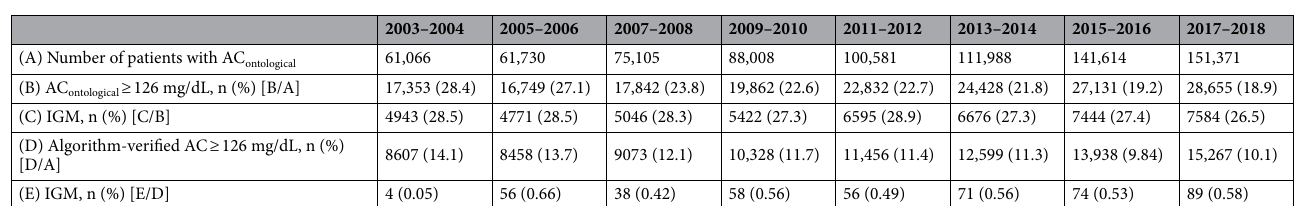
Table 4. Prevalence of fasting glucose ≥ 126 mg/dL and the proportion of ineffective glucose measurement (IGM) from 2003 to 2018 at China Medical University Hospital. The alphabet A to E represents the number of each condition and the proportion of each condition from B to E is derived from the ratio indicated in the